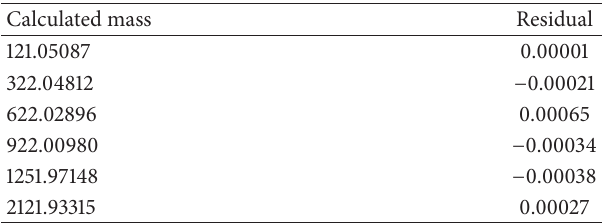
Table 3: Residues of calibration at positive mode by DSA-TOF-MS. Calculated mass Residual 121.05087 0.00001